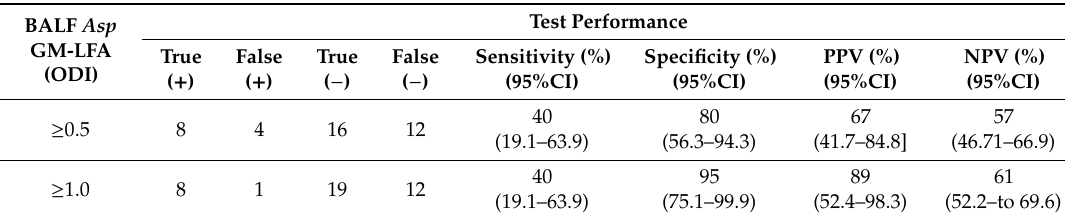
Table 3. Evaluation of IMMY Aspergillus galactomannan lateral flow assay ( Asp GM-LFA) on bronchoalveolar lavage fluid (BALF) from 20 patients with proven or probable invasive pulmonary aspergillosis and 20 control